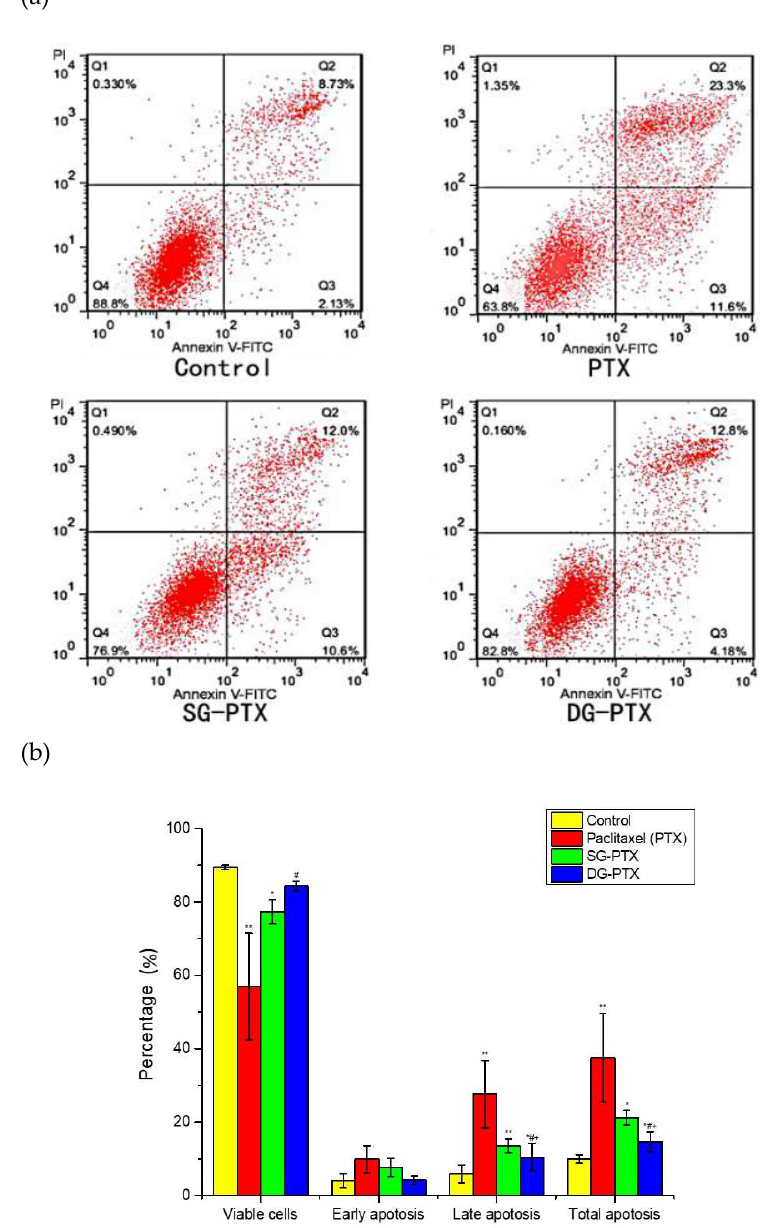
Figure 6. Cell apoptosis inducing effect of PTX and PTX prodrugs on MDA-MB-231 cells. ( a ) Apoptosis of MDA-MB-231, ( b ) Quantification of apoptosis data. All values are expressed as mean ± SD (n = 3). Compared to control group, * p <0.05, ** p < 0.01; compared to PTX group, # p < 0.05; compared to SG-PTX group, + p < 0.05.